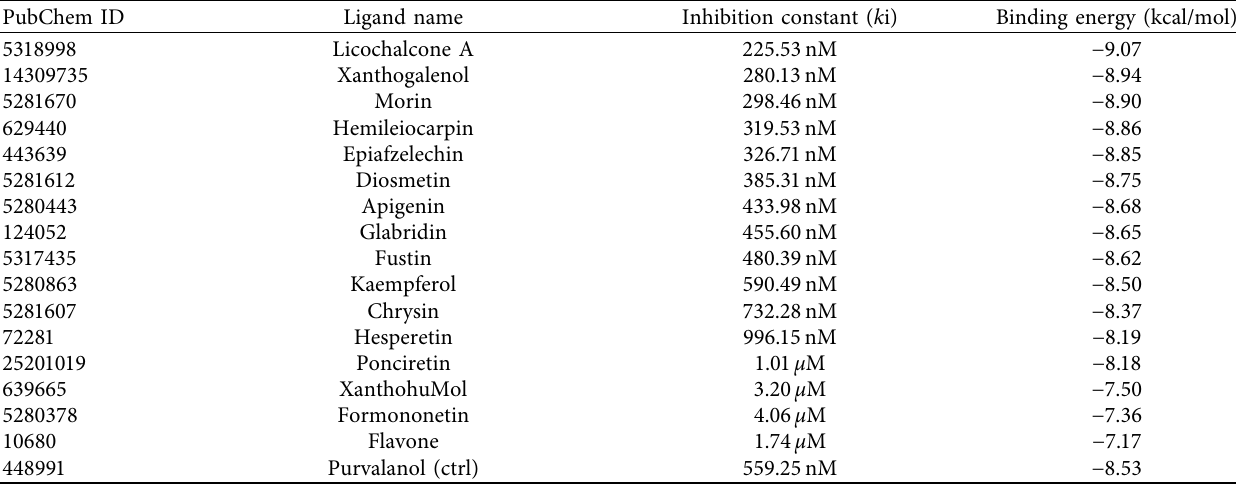
MAPK3, mitogen-activated protein kinase 3; ctrl, control. Table 2: Details of energies between top-ranked favonoids, positive control inhibitor, and MAPK3 catalytic site, achieved from the AutoDock tool.